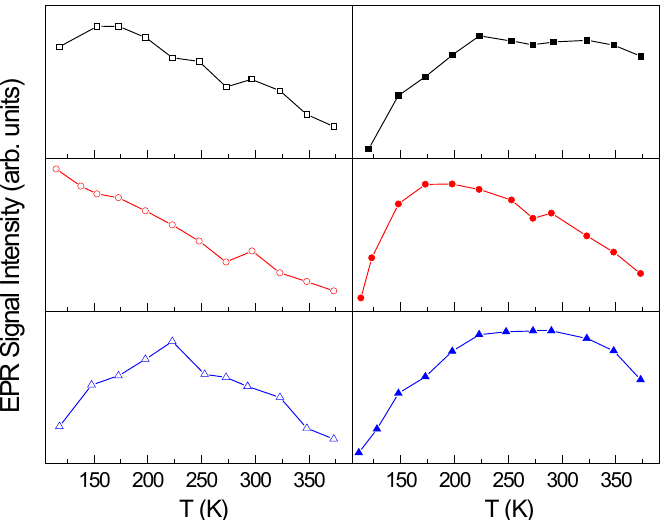
Figure 7. The trend of signal intensity (area) for slowly cooled (left column) and quenched (right column) samples vs. temperature. Black, red, and blue symbols represent undoped, Cu-doped, and Fe-doped samples, respectively.